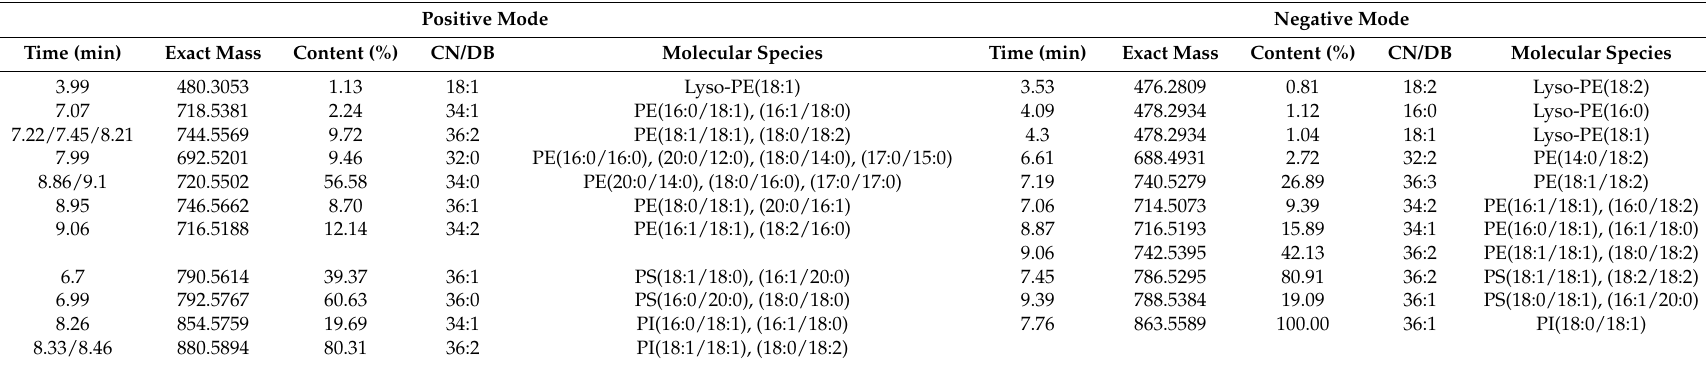
Table 5. Glycerophospholipid classes: Phosphatidylethanolamine (PE), phosphatidylinositol (PI) and phosphatidylserine (PS) content in the F1 fraction of buttermilk as determined by UPLC/QToF-MS. The acyl chain compositions of the molecular species are